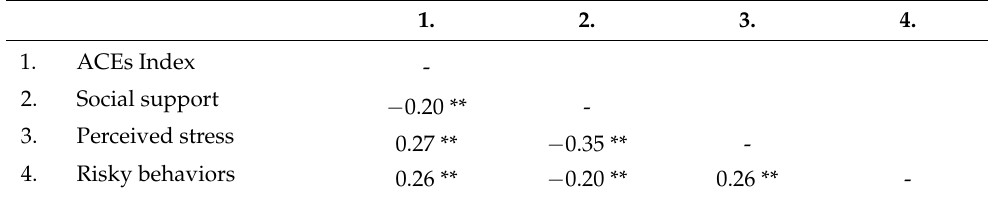
Table 2. Correlations between ACEs, social support, perceived stress, and total risky behaviors.